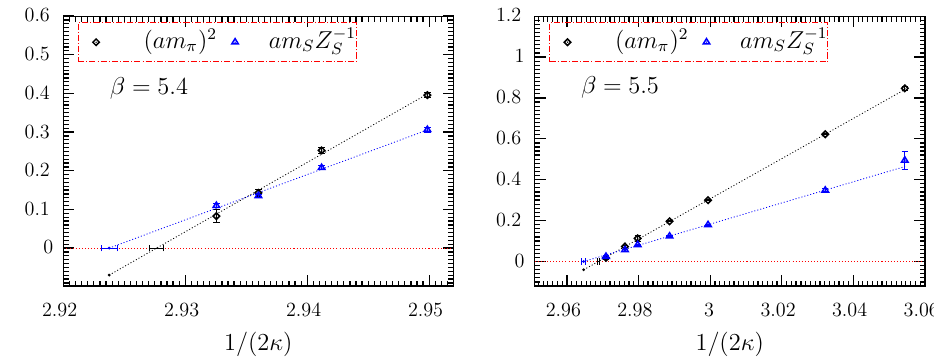
Fig. 1 The subtracted gluino mass am S Z − 1 and the squared adjoint pion mass ( am a– π ) 2 as a function of 1 /( 2 κ) , and the corresponding extrapo- S lations towards the chiral point ( κ c ) for two values of β